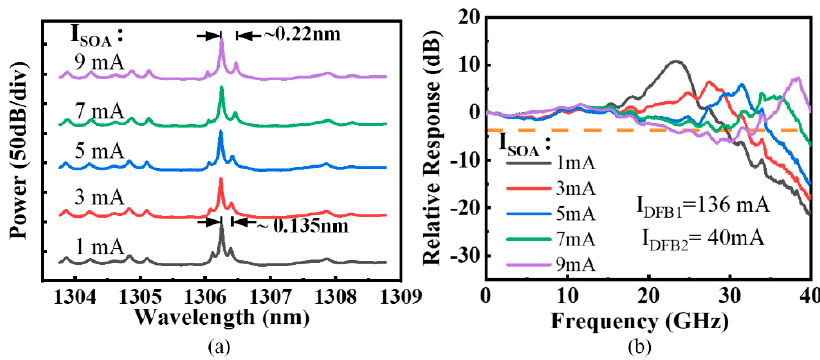
Figure 8. ( a ) Lasing spectra and ( b ) corresponding small-signal modulation response of the IMC laser with different I SOA values. Here, I DFB1 and I DFB2 were fixed at 136 and 40 mA, respectively.